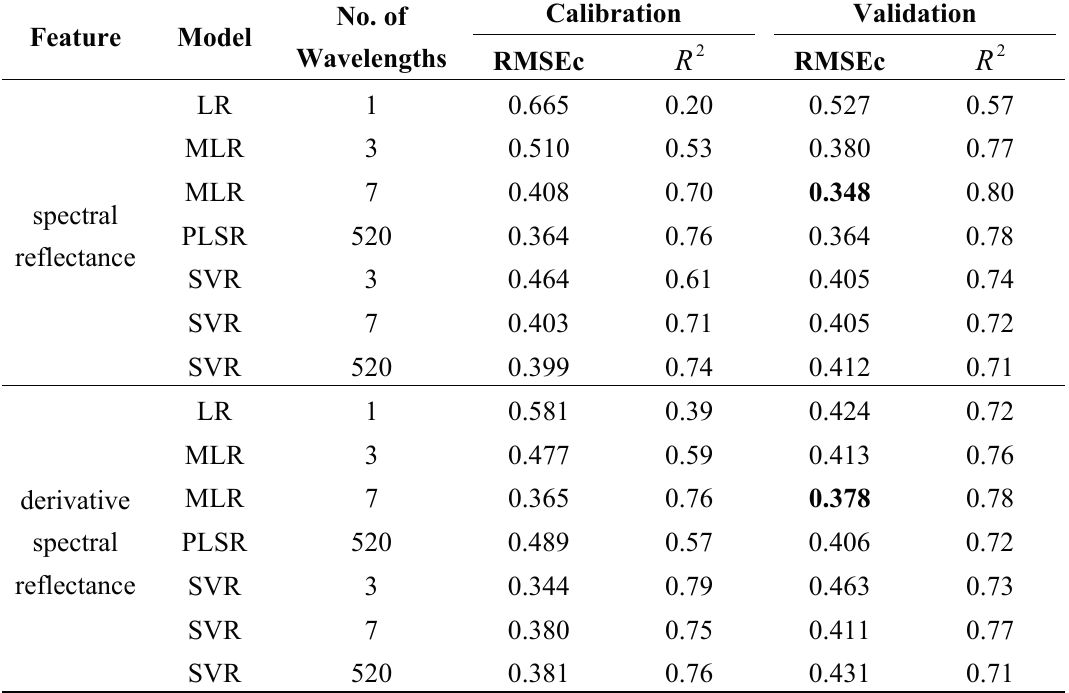
Table 3. Spectral variables and chlorophyll content retrieval accuracies for the different models (ASD